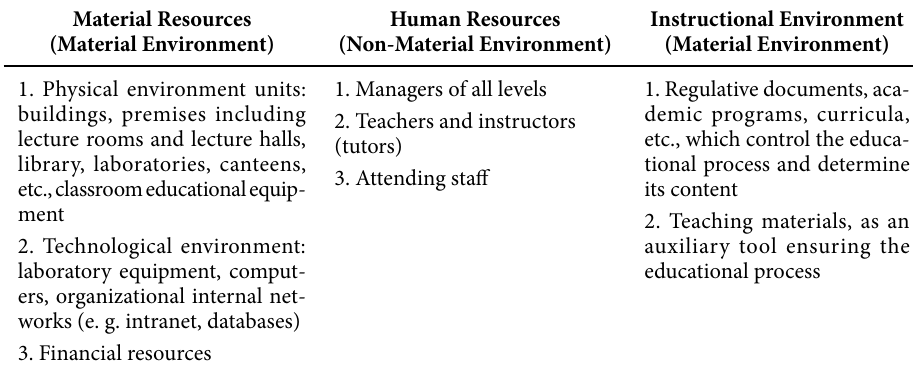
Table 2. The basic constituents of the internal educational environment Material Resources (Material